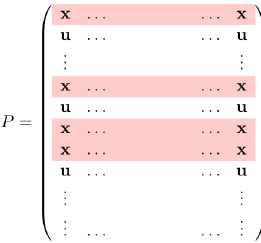
Figure 1: The incompletely sampled matrix P . In this figure, the shadowed rows x denote the known entries and the u denote the unknown entries. The shadowed part of rows has the index set [ k ] , the unknown rows have the index set [ n − k ]